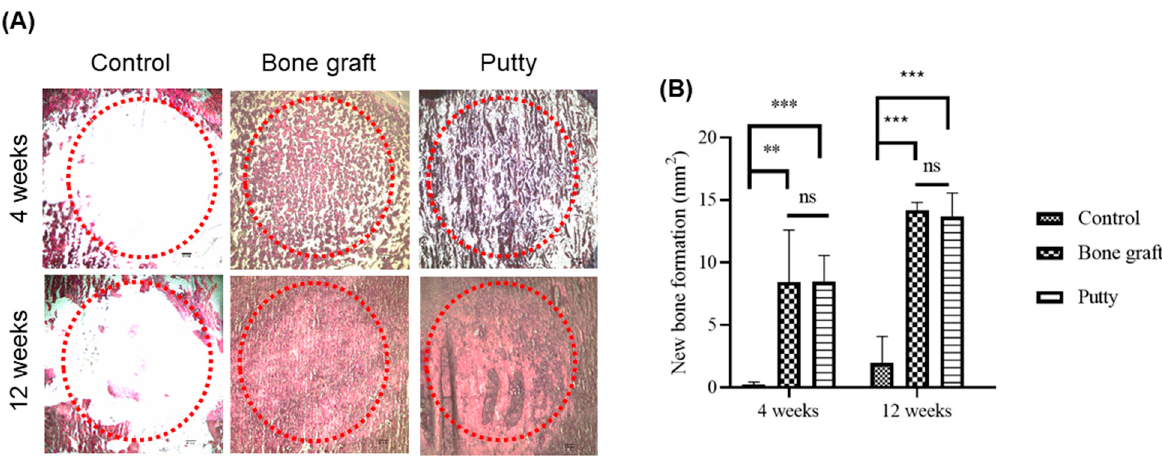
Figure 8. Alizarin Red S staining histochemical examination of new bone collagen in the critical-sized bone defects. ( A ) Representative femoral sections were stained with Alizarin Red S staining of the critical-sized bone defect. ( B ) Alizarin Red S staining quantification of new bone formation in the bone graft and putty after implantation. The red dotted circle indicates the critical-sized bone defect. The significance was set at ns- ( p > 0.05), **—( p < 0.001), ***—( p < 0.0001). At 12 weeks, bone graft implanted defects a significant ( p < 0.0001) increase in the Alizarin Red S staining was found in the bone graft implanted defect compared to the control. Putty implanted defect at 12 weeks showed a significant ( p < 0.0001) increased Alizarin Red S staining relative to control bone defect, indicating osteogenesis leading to the new bone formation was complete by putty during bone regeneration. The bone graft implanted defect compared to the putty implanted defect portrayed non-significant changes in Alizarin Red S staining. 4. Discussion To the best of our knowledge, this is the first study to evaluate the “putty” made solely by employing supercritical fluid extraction technology from porcine bone and hide; the putty is easy to handle and efficient in bone regeneration. The critical-sized bone de- fect management is considered a big task, and substitute materials for implantation are required [13]. At present various approaches have been established for the augmentation of critical-sized bone defects, which include autologous bone transplantation and the use of allografts [14,15]. Nevertheless, the aforementioned strategies had limitations that hin- dered their frequent use [16]. Bone graft alternatives offer physicians an “off the shelf” substitute to help heal defects. The perfect bone graft material criteria are; handling well during surgery, effortlessly implanted into the defect, and finally functioning as an oste- oconductive scaffold to assist and restore the defect. The vast number and numerous var- iations of bone graft materials that have been established as well as used clinically are noteworthy [17,18], indicating that we still need to find the ideal bone graft candidate for clinical use [17]. In the present study, the putty retained the tubular structure after placing it in the saline, indicating that it can retain its shape and structure and attach to bone. The putty produced had excellent physical properties, such as retaining the structure and stickiness, along with excellent bone regenerative properties (Table 2).